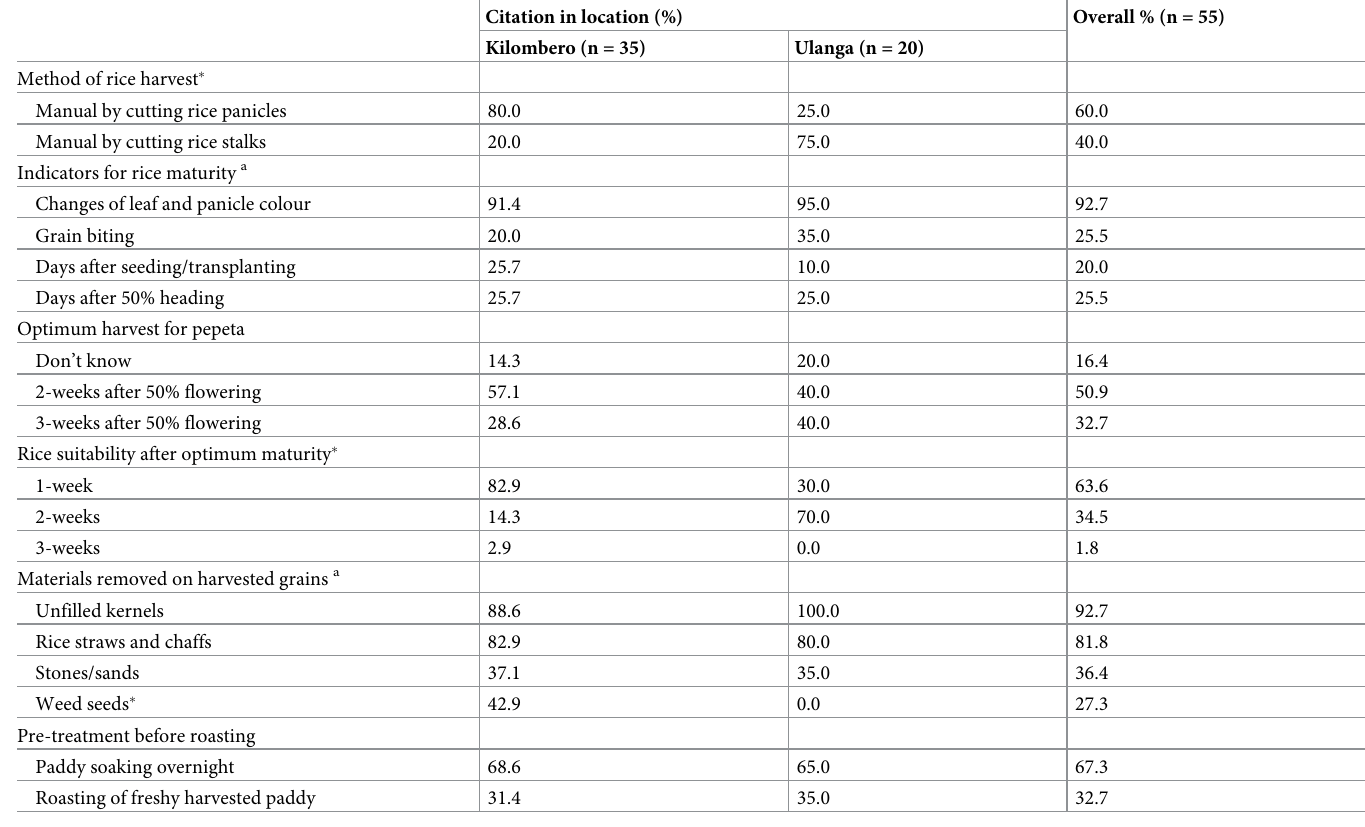
Table 7. Overview harvesting of immature rice grains and its preparation before pepeta